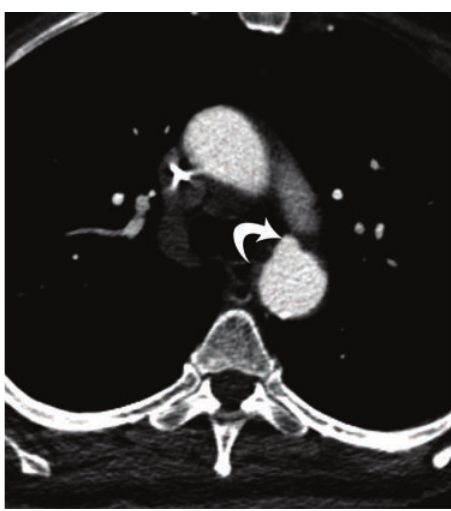
Figure 10: Acute traumatic aneurysm—postcontrast axial CT scan image in a 28-year-old male who was involved in a motor vehicle accident shows a small focal outpouching from the anterior aspect of the proximal descending thoracic aorta (curved arrow), which is indicative of aortic trauma. Note the absence of mediastinal hematoma in this